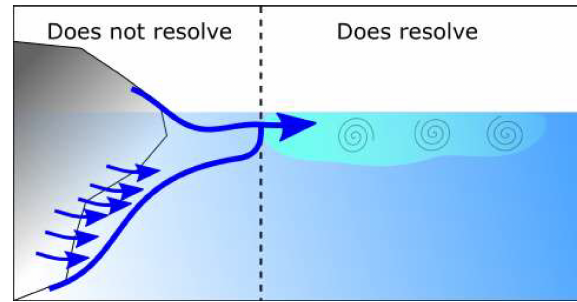
Figure 3. The schematic shows how the model injects meltwater. The left side of the figure shows what the model cannot resolve. This includes a glacier, small-scale melting from the glacier, and the plume dynamics that occur along the face of the glacier. Instead, the model resolves larger-scale processes that occur along the coastline, and therefore injects the meltwater from the GrIS at the first ocean model layer at the surface, which then is mixed over a thickness of